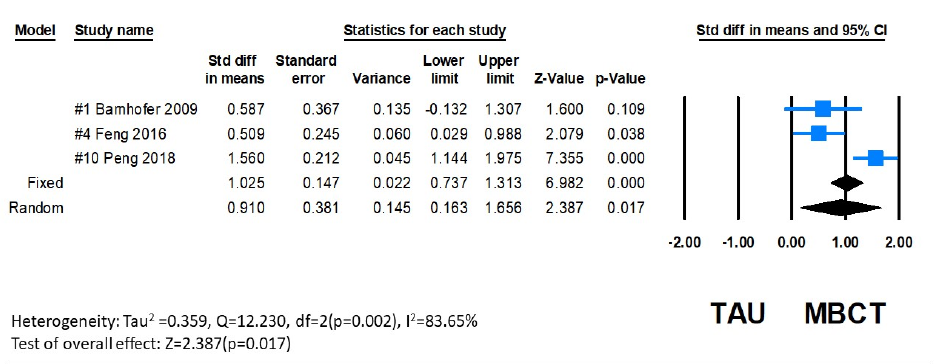
Figure 8. Forest plot of suicidal ideation effect of MBCT on depression.